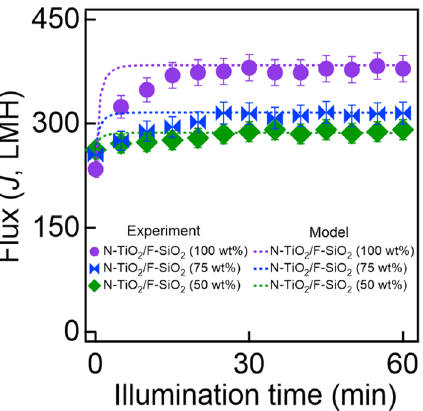
Figure 4. The measured and the predicted values of water-rich permeate flux ( J ) by using Eq. (4) through the meshes coated with varied compositions of N-TiO 2 /F-SiO 2 under visible light illumination ( I = 198 mW cm −2